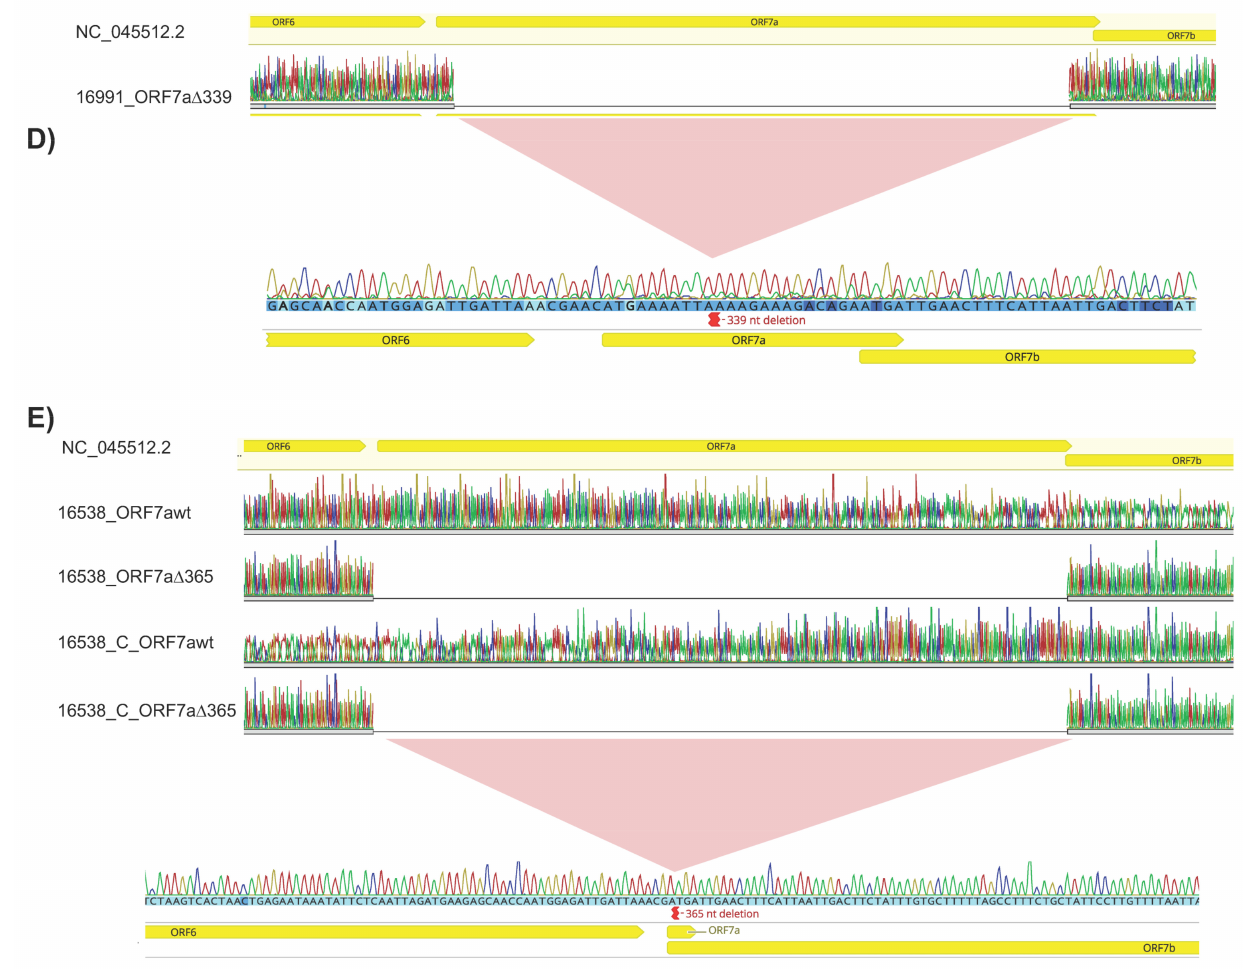
Figure 2. Amplification and confirmation of 339 and 365-nt deletion amongst co-workers. ( A ) ORF7a 339-nt and 365-nt deletions visualization in a group of co-workers on agarose gel (2%) stained with ethidium bromide revealed the PCR products targeting ORF7a gene: 16305_ORF7a_wt, 16553_ORF7a_wt, 16538_ORF7a_ ∆ 365, 16991_ORF7a_ ∆ 339; 100bp Molecular Weight Marker (lane M). ( B ) Prevalence of viral genomic deletion analyzed through ORF7a PCR products from serial dilutions (10 − 1 –10 − 4 , lane 2–5, respectively) of sample 16538_ORF7a_ ∆ 365 viral stock and visualized on agarose gel (2%) stained with ethidium bromide. The two PCR fragments are present in 10 − 1 and 10 − 2 , and only the non-deleted fragment is present in 10 − 3 and 10 − 4 . ( C ) Eleven virus plaques were isolated from sample 16538. RNA extraction, reverse transcription, and PCR using primers that target the ORF7a region were performed. PCR products were visualized on agarose gel (2%) stained with ethidium bromide. Each lane corresponds to a virus plaque (P1–P11) derived from sample 16538. Virus plaques P2, P4 and P11 correspond to the virus without deletion in the ORF7a region, and virus plaques P5, P6 and P7 correspond to the virus with 365-nt deletions in the ORF7a region (ORF7a_ ∆ 365). M = 100 bp Molecular Weight Marker. ( D ) Electropherograms from Sanger sequencing of the ORF7a PCR products from sample 16991_ORF7a_ ∆ 339 aligned to SARS-CoV-2 reference and its deletion-resulting sequence ( E ) Electropherograms of both ORF7a PCR products isolated on a gel, from clinical samples and viruses isolated from cell culture (lanes P2 and P5, ( B )) of 16538 ORF7a WT and the ORF7a_ ∆ 365 of 16538_ORF7a_ ∆ 365 and the non-deleted counterpart of 16538 * Samples submitted to NGS sequencing † Samples submitted to Sanger